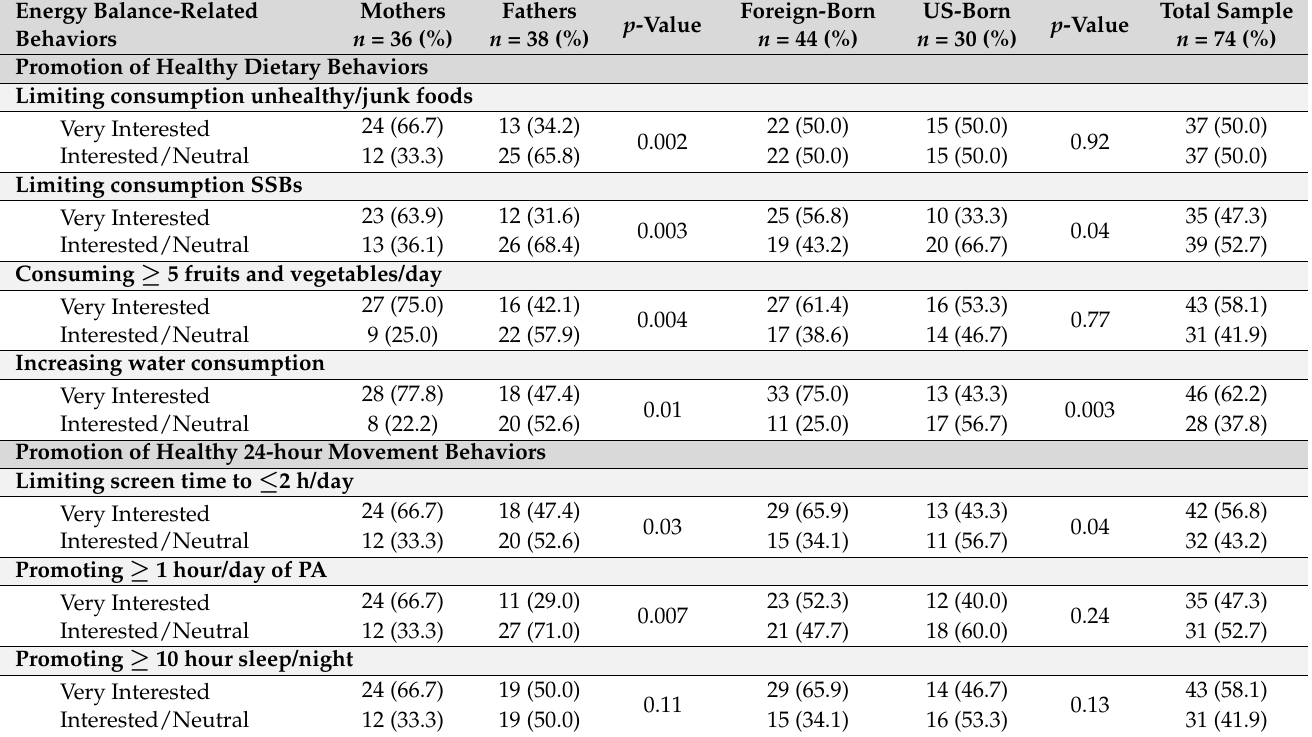
Table 2. Participants’ preferences for informational content to promote healthful energy balance- related behaviors of their preschool-aged